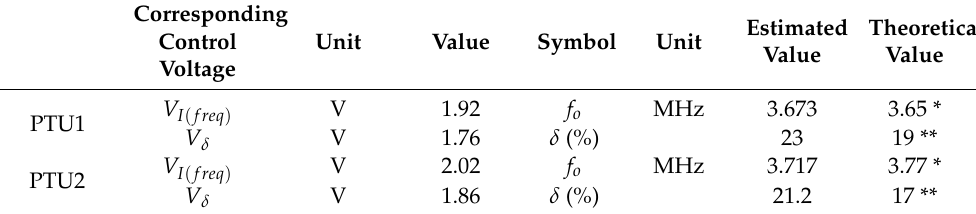
Table 5. Control voltage inputs of the individual PTUs in Figure 23. Corresponding Control Unit Value Symbol Unit Voltage